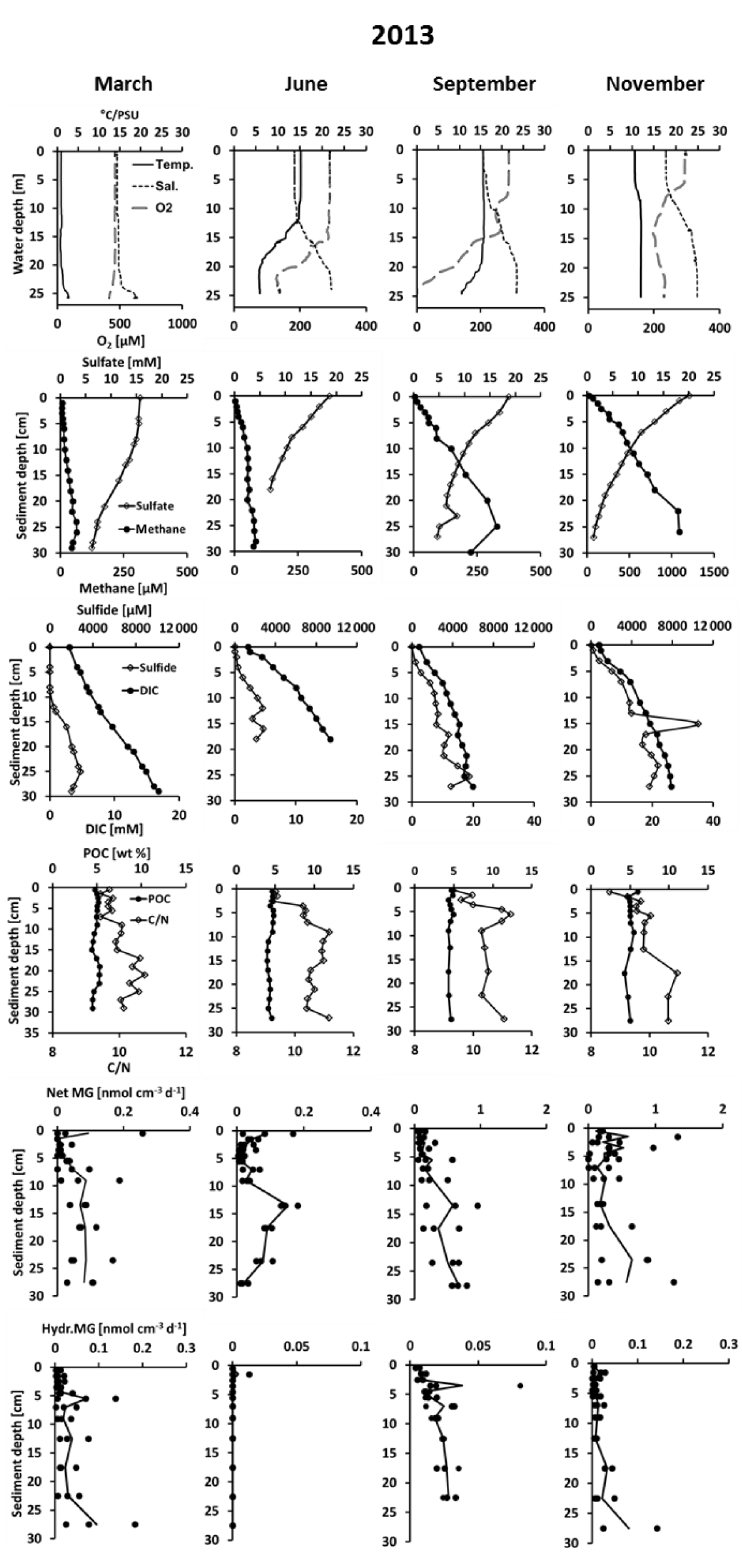
Figure 2. Parameters measured in the water column and sediment in the Eckernförde Bay in each sampling month in the year 2013. Net methanogenesis (MG) and hydrogenotrophic (hydr.) methanogenesis rates are shown in triplicates with mean (solid